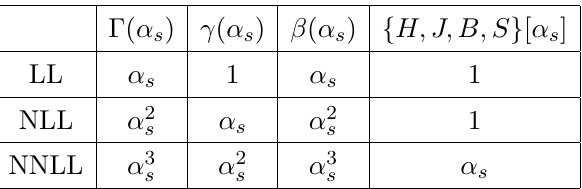
Table 1 . Resummation accuracy and corresponding order of individual ingredients: cusp and non- cusp anomalous dimensions, beta function, and fixed-order hard, jet, beam, soft functions. that our modification in profile function provides access to minimum scale Q and a = 0 . 5